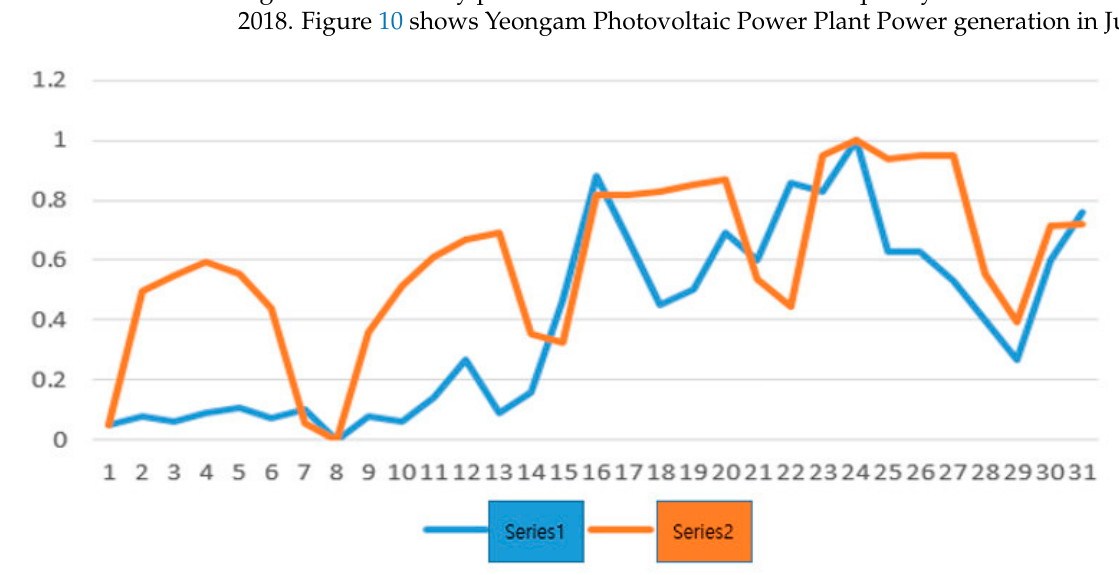
Figure 9. Daily power demand and search frequency for “intense heat” in July 2018.